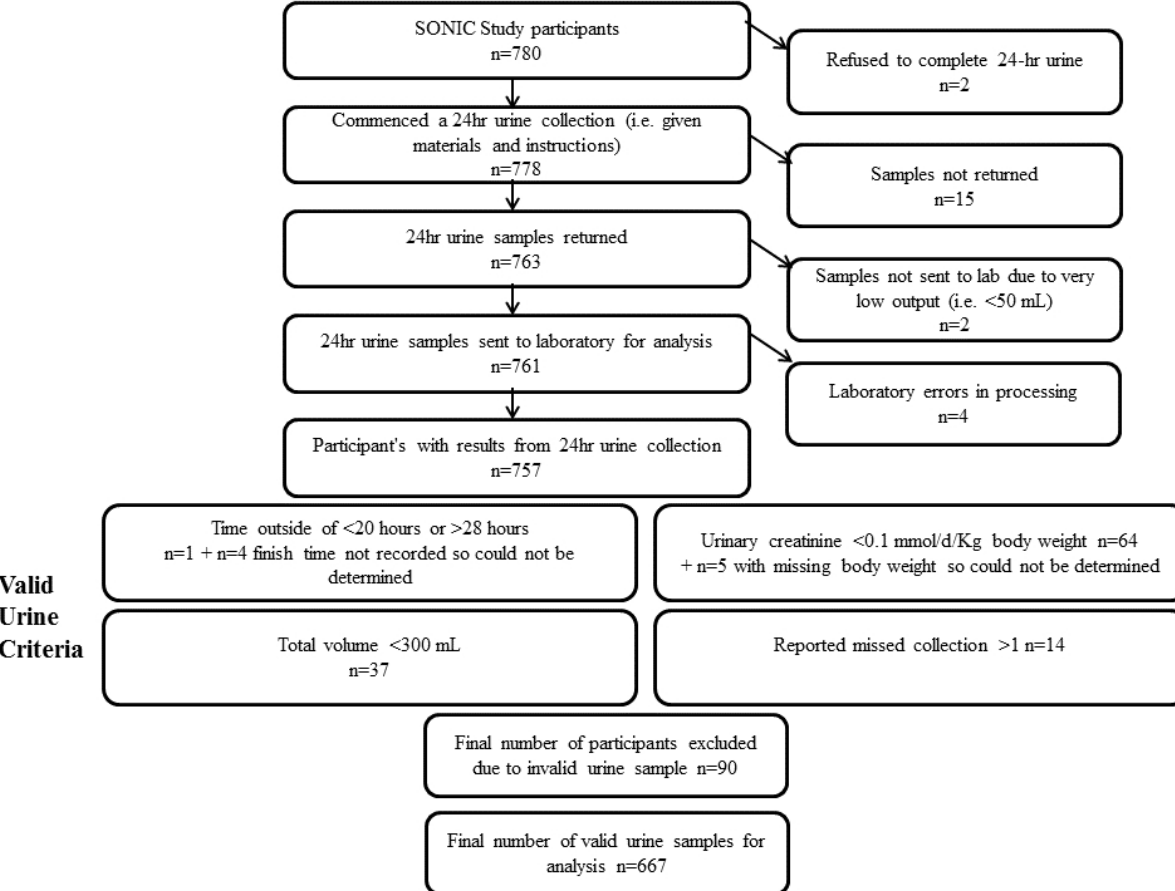
Figure 3. Flow chart of assessment of valid 24-hour urine collections for